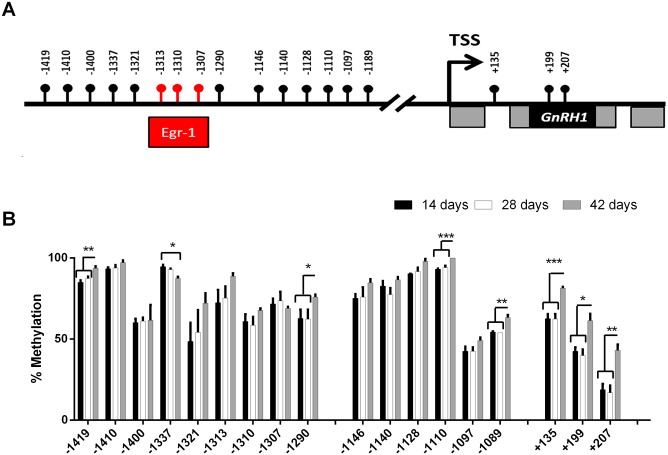
DNA methylation of the GnRH1 gene during development
(A) Physical map of the GnRH1 promoter and coding region. Location of the Egr-1 binding site in red. Coding regions in black, non-coding in gray. TSS is the transcription start site (B) Fractional methylation in the GnRH gene at 18 positions on the GnRH gene for three different developmental time points, 14- (white), 28- (grey), and 42-days (black) * = p<0.05, ** = p<0.001, *** = p<0.0001. (n = 5–7 /group). Error bars represent s.e.m.